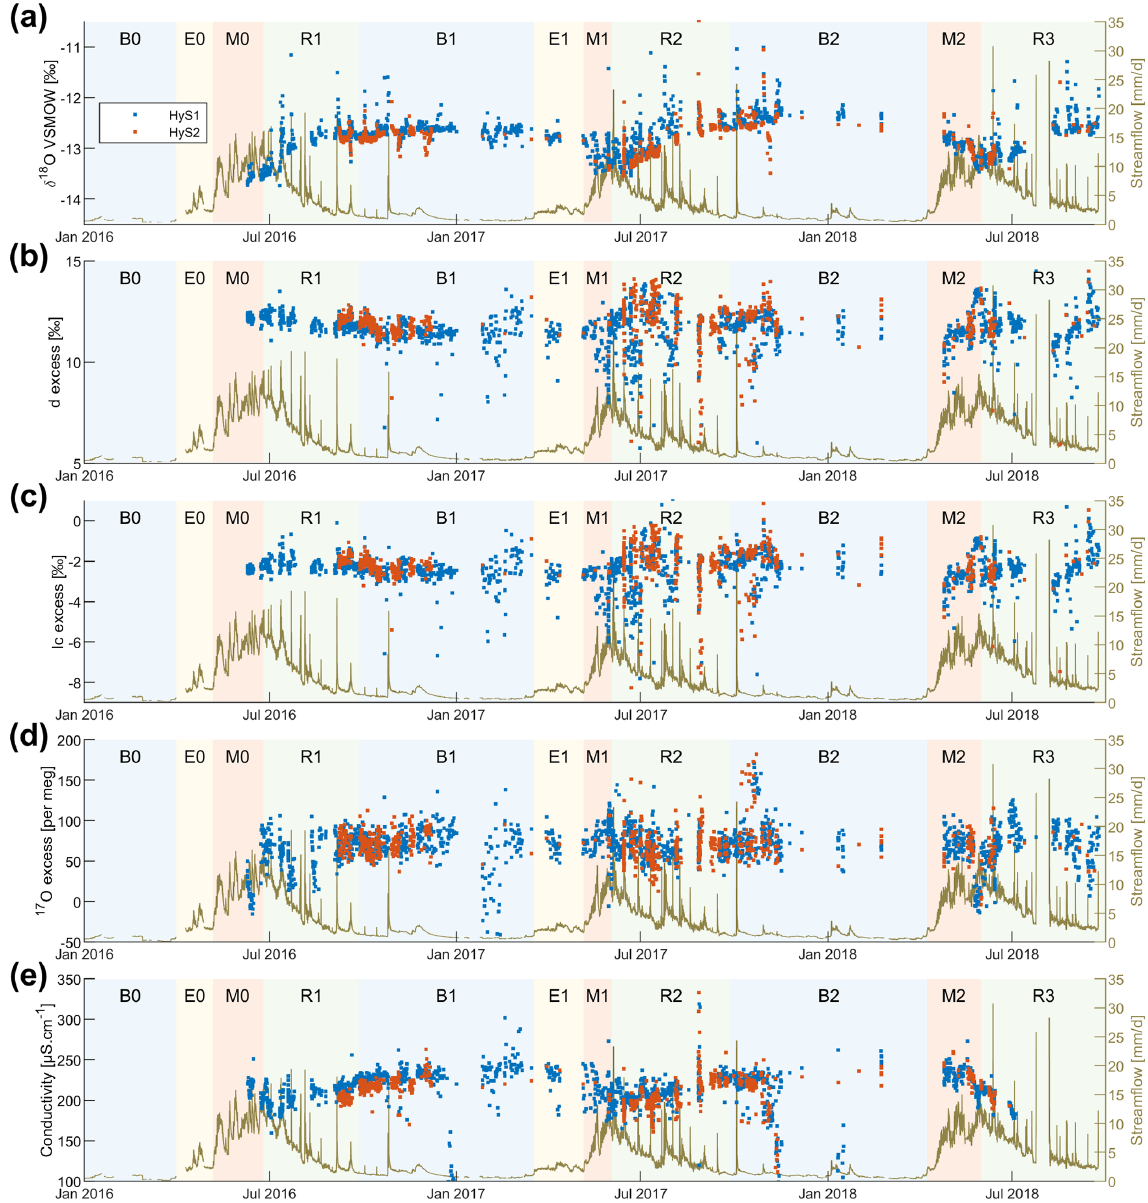
Figure 6. Time series of δ 2 H, δ 17 O, δ 18 O, conductivity, d-excess, lc-excess, and 17 O-excess at the Vallon de Nant outlet HyS1 and at the upper subcatchment HyS2 (location in Fig.